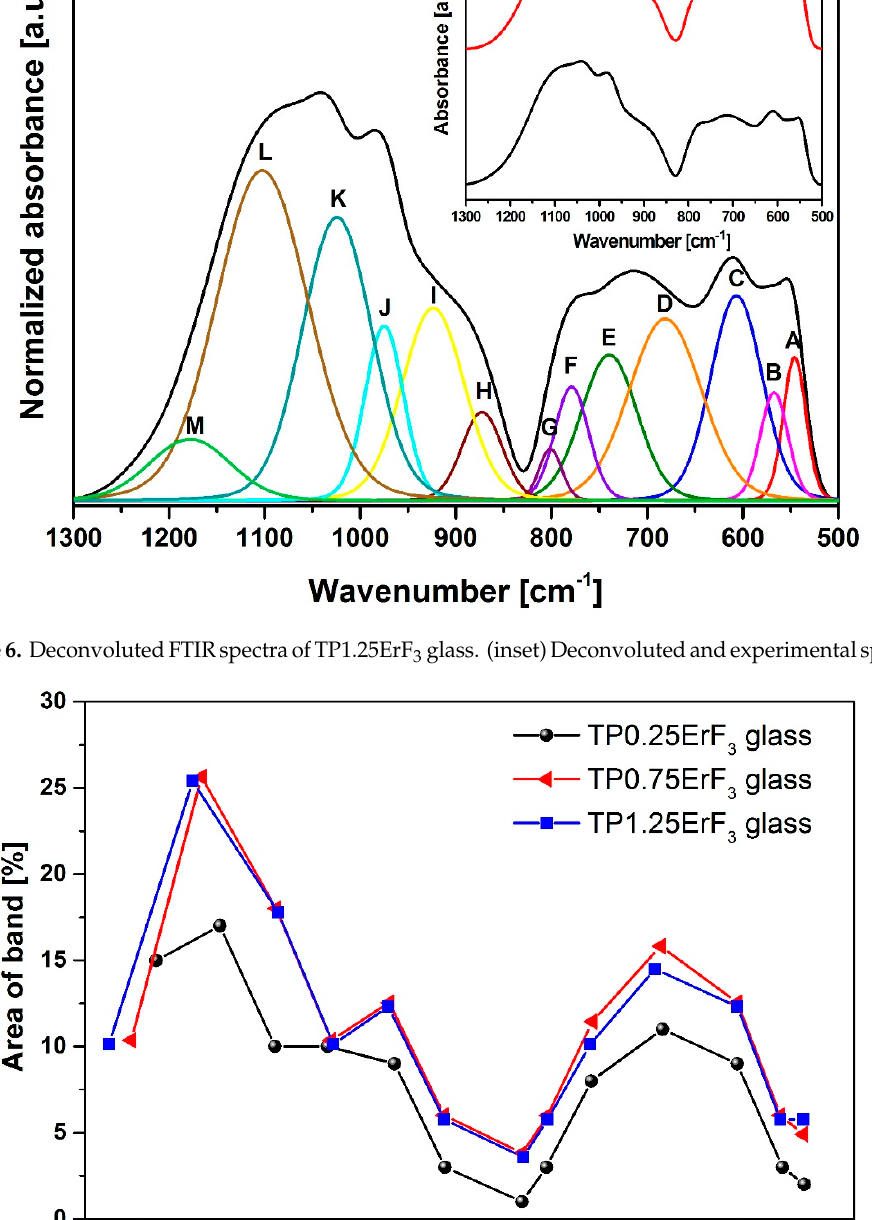
Figure 7. Plot of bands position and their area for deconvoluted FTIR spectra of the TP0.25ErF 3 , TP0.75ErF 3 , and TP1.25ErF 3 glasses. Table 2. The parameters of bands obtained by deconvolution of the FTIR spectra of TP0.25ErF 3 , TP0.75ErF 3 , and TP1.25ErF 3 glasses.